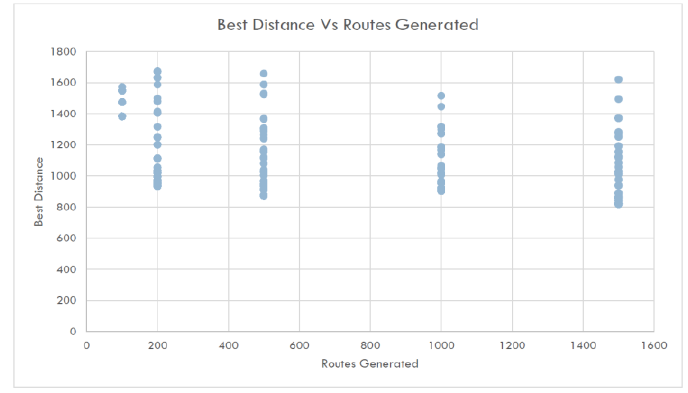
Fig. 2. Route Best Distances Compared to Number of Routes